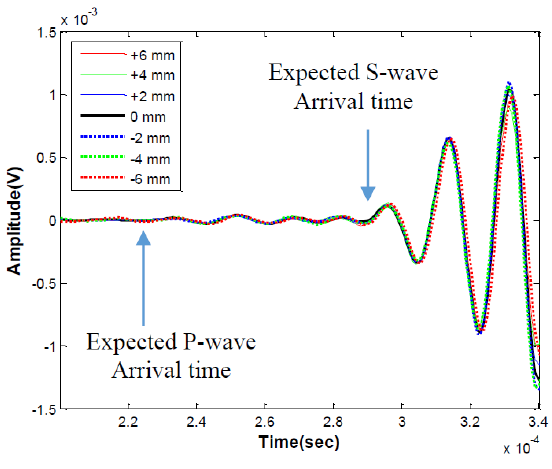
Figure 13. Time signals obtained from MEMS array perpendicular to surface wave propagation on PMMA; seven sensors are spaced 2 mm apart in the